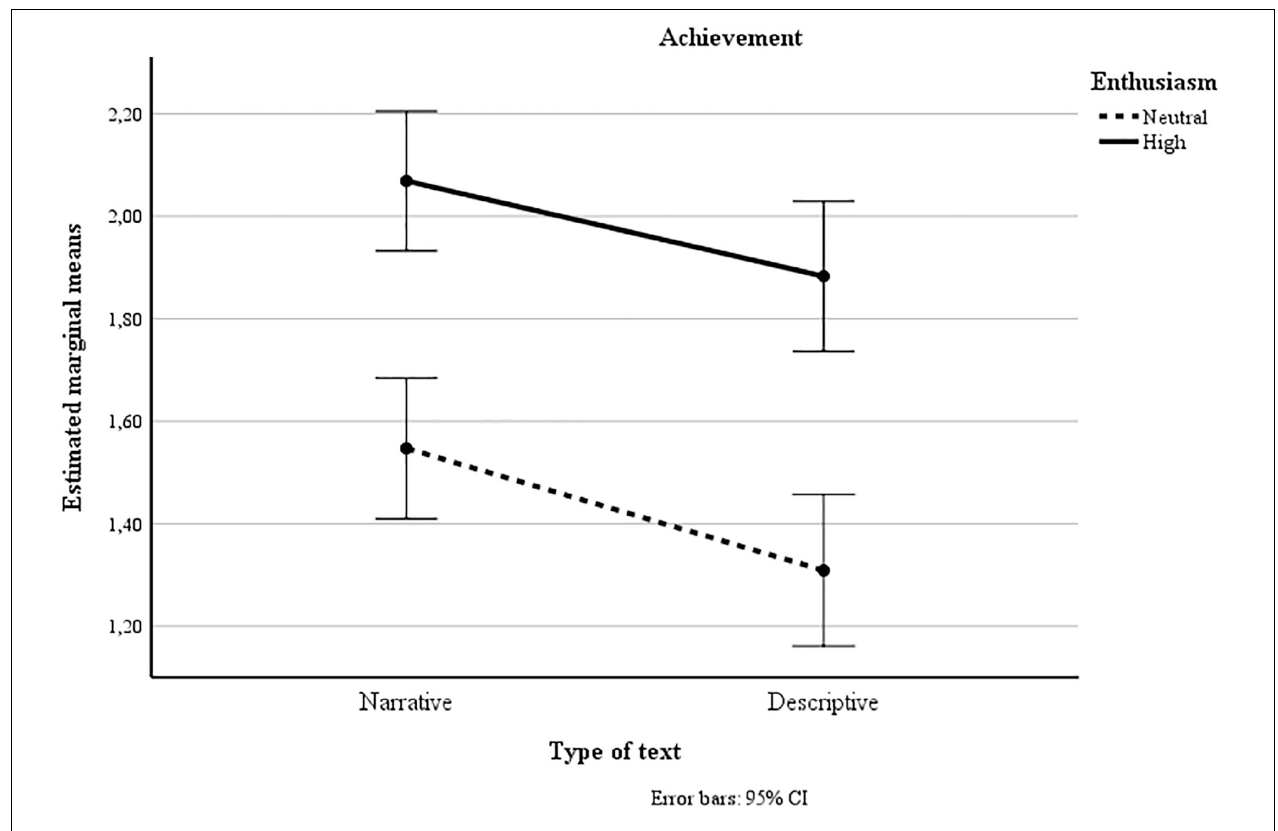
FIGURE 2 | Estimated marginal means for achievement, by teacher enthusiasm and type of text.